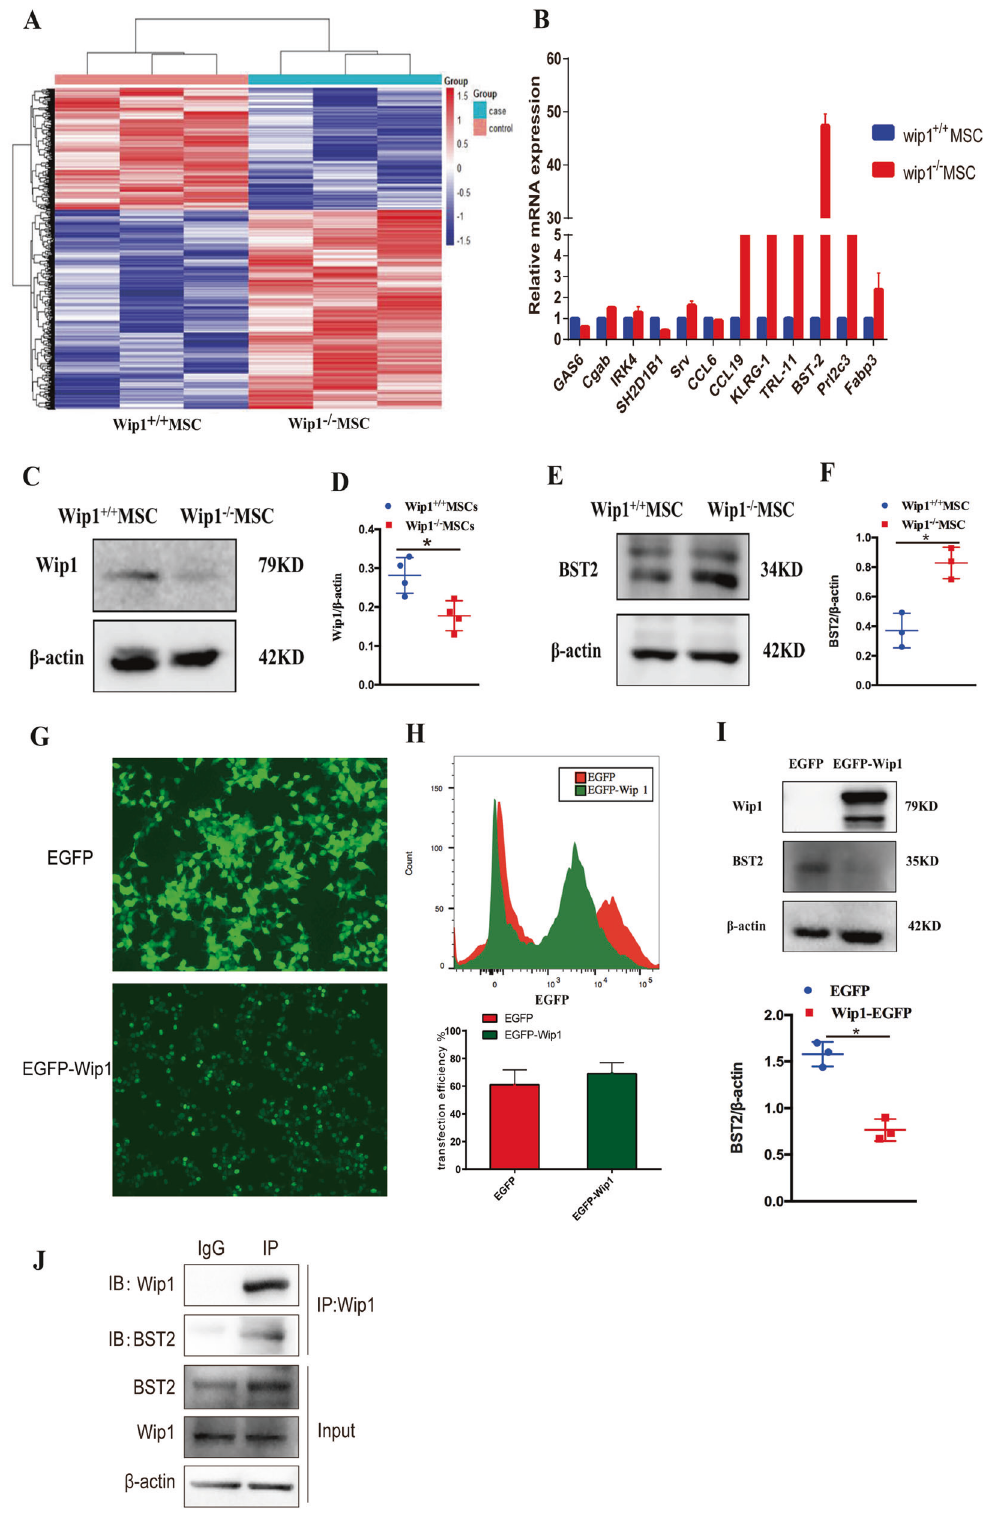
Fig. 4 Wip1 interacted with BST2. A The RNA transcripts heatmap of Wip1 + / + MSCs and Wip1 − / − MSCs was displayed by Microarray analysis. B The upregulated genes in Wip1 + / + MSCs and Wip1 − / − MSCs were determined by qPCR. C – F Western blot was used to con fi rm the protein expression of Wip1 and BST2 in Wip1 + / + MSCs and Wip1 − / − MSCs. G Wip1-EGFP and EGFP plasmids were transfected into 293 T cells, and the positive cells were observed by fl uorescence microscope. H The transfection ef fi ciency of Wip1-EGFP and EGFP plasmids in 293 T cells was detected by fl ow cytometry. I Western blot assay was utilized to determine the endogenous interaction between Wip1 and BST2 in 293 T cells. J Co-IP assay was used to detect the interaction between endogenous Wip1 and BST2 in MSCs cells. * P < 0.05.